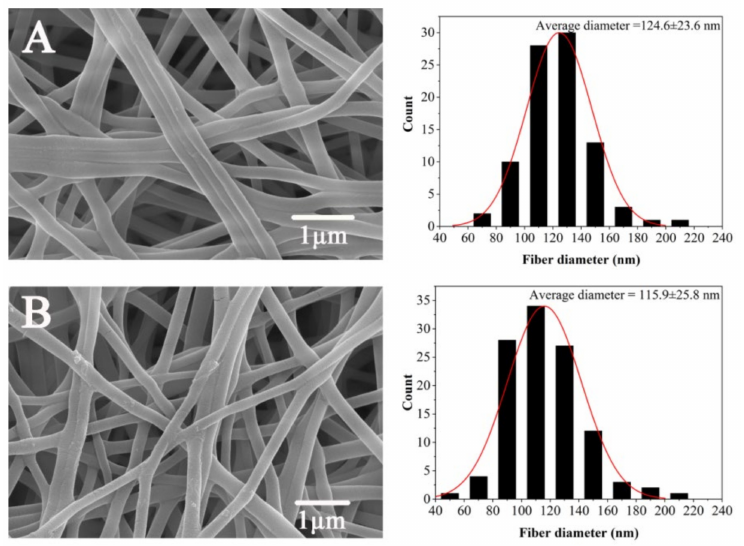
Figure 5. Scanning electron microscopy of nanofiber membrane (( A ) CS:PVA = 3:7; ( B ) CS:PVA = 2:8).